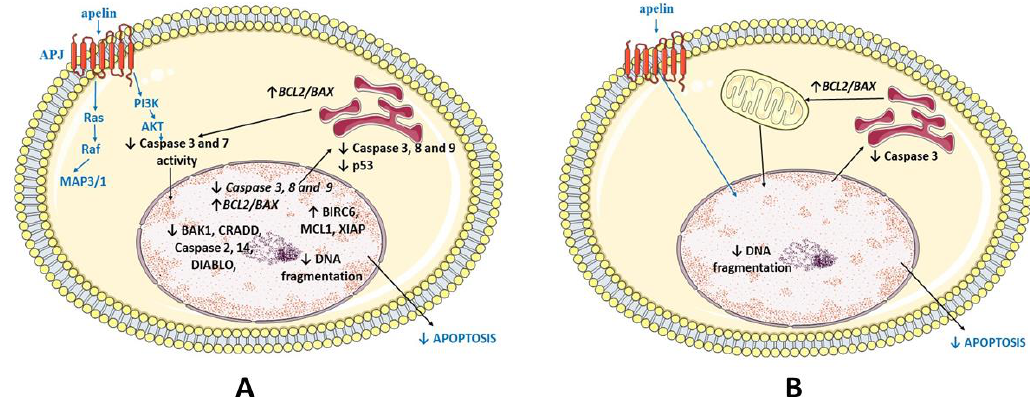
Figure 7. Model of apelin antiapoptotic action in BeWo cell line ( A ) and human placenta explants ( B ). Apelin inhibits apoptosis by activation of apelin receptor (APJ), mitogen-activated kinase (MAP3/1) and protein kinase B (AKT); BCL2 (B-cell lymphoma 2), BAX (Bcl-2-like protein 4); BAK1 (Bcl-2 homologous antagonist/killer); BOK (Bcl-2-related ovarian killer protein); NOD1 (Nucleotide-binding oligomerisation domain-containing protein 1); CRADD (Caspase and RIP adapter with death domain); DIABLO (Diablo IAP-Binding Mitochondrial Protein); TNFRSF25 (Tumour necrosis factor receptor superfamily member 25); BIRC6 (Baculoviral IAP repeat-containing protein 6); MCL1 (Induced myeloid leukaemia cell differentiation protein MCL1); XIAP (X-linked inhibitor of